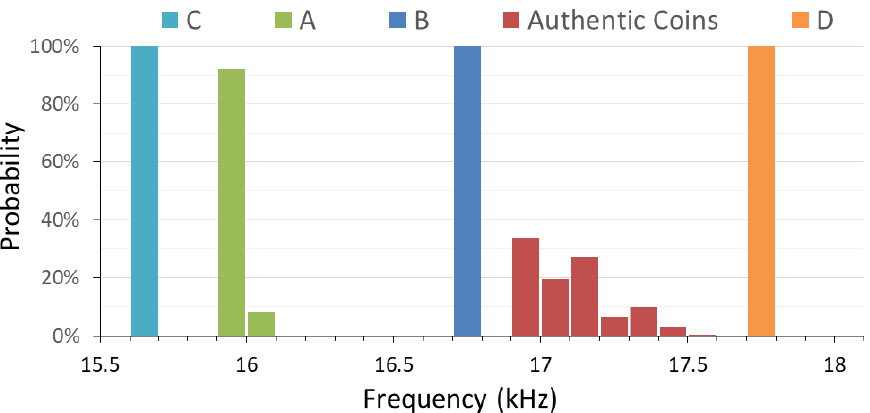
Figure 13. The classification result of the authentic and possible counterfeit coins tested by the proposed EMAT coin identification system with a microcontroller.